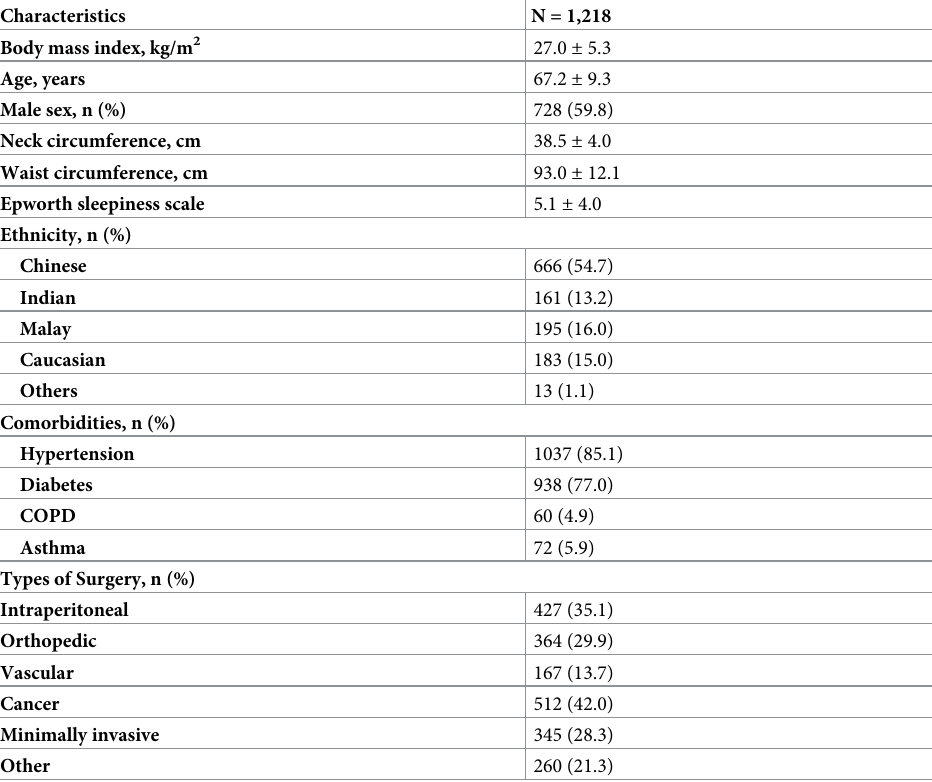
Table 1. Characteristics of